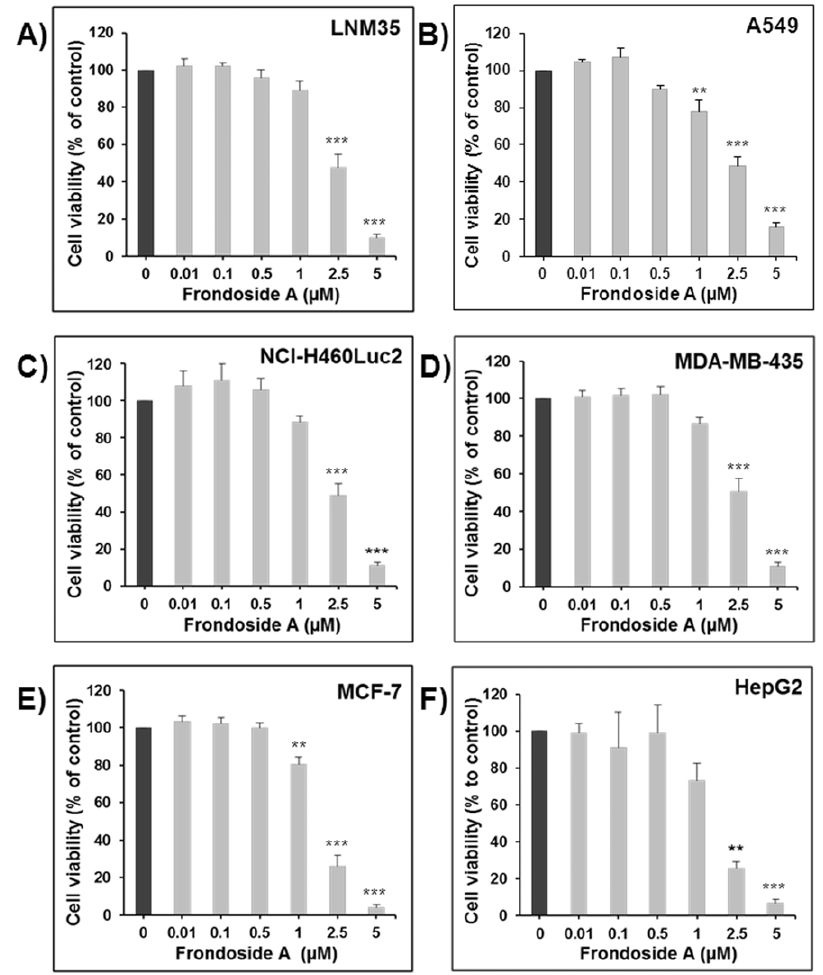
Figure 1. Inhibition of cellular viability by Frondoside A. Exponentially growing LNM35 ( A ), A549 ( B ), NCI-H460-Luc2 ( C ), MDA-MB-435 ( D ), MCF-7 ( E ), and HepG2 ( F ) cells were treated with vehicle (0.1% DMSO) and the indicated concentrations of Frondoside A. Viable cells were assayed as described in Materials and Methods. All experiments were repeated at least three times. Columns , mean; bars , S.E.M. ** Significantly different at P , 0.01, *** Significantly different at P , 0.001.